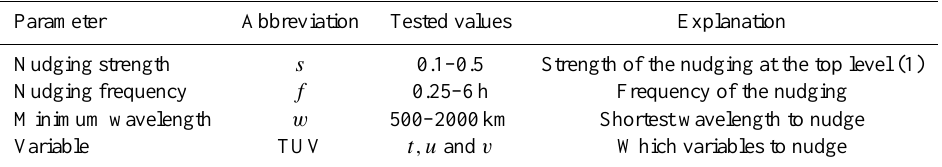
Table 1. Tuning parameters for the spectral nudging